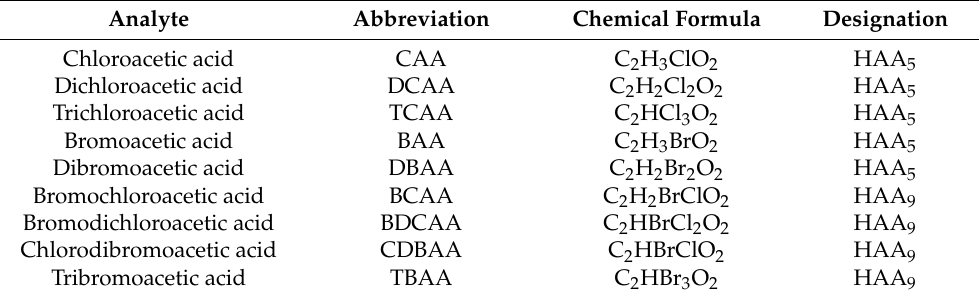
Table 1. The nine brominated and chlorinated haloacetic acids (HAAs) and their common abbrevia- tions and structures. This study focuses on the first